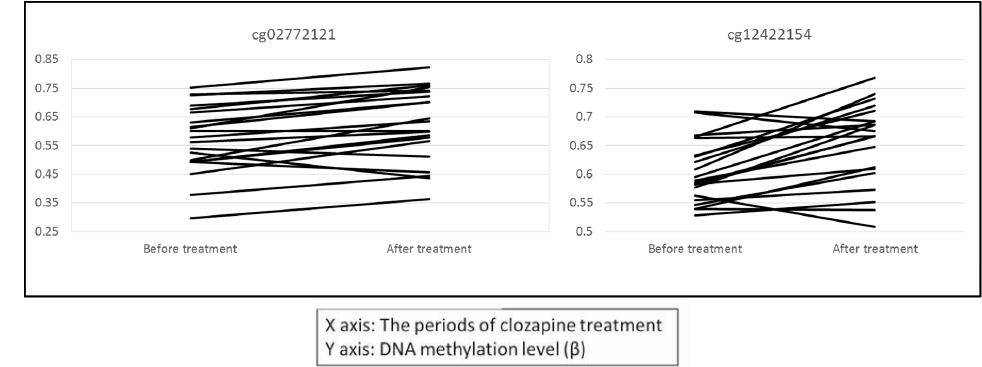
Figure 2. DNA methylation changes following clozapine treatment in the TRIM15 gene. Clozapine caused increased DNA methylation changes at two CpG sites (cg02772121 and cg12422154) in the promoter region of the TRIM15 gene ( p = 3.2 × 10 − 4 , and p = 2.5 × 10 − 4 , respectively).